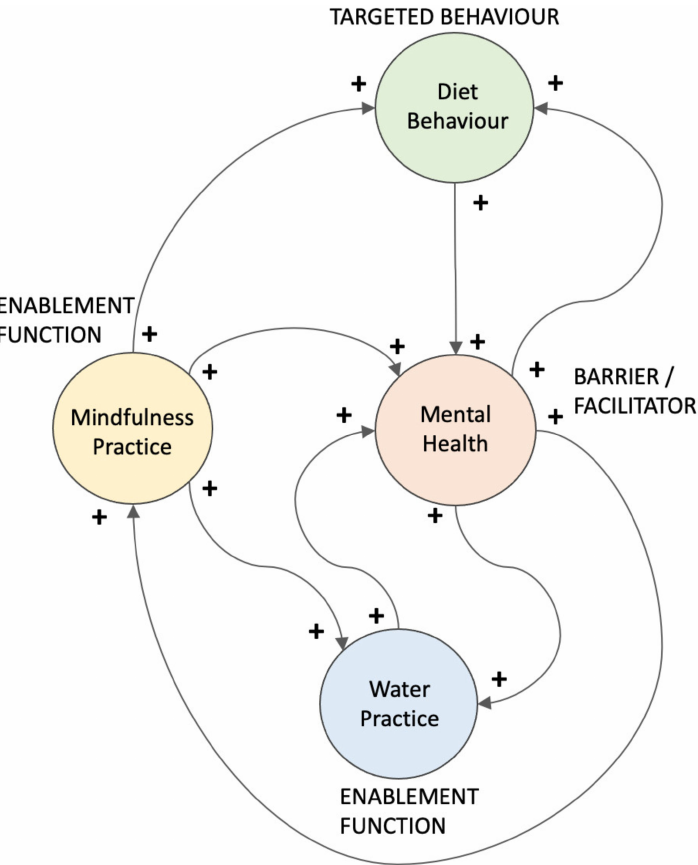
Figure 10. Relationship between the targeted diet behaviour, the barrier/facilitator of mental health and the enablement functions of mindfulness and water practice, showing the presence of multiple self-reinforcing